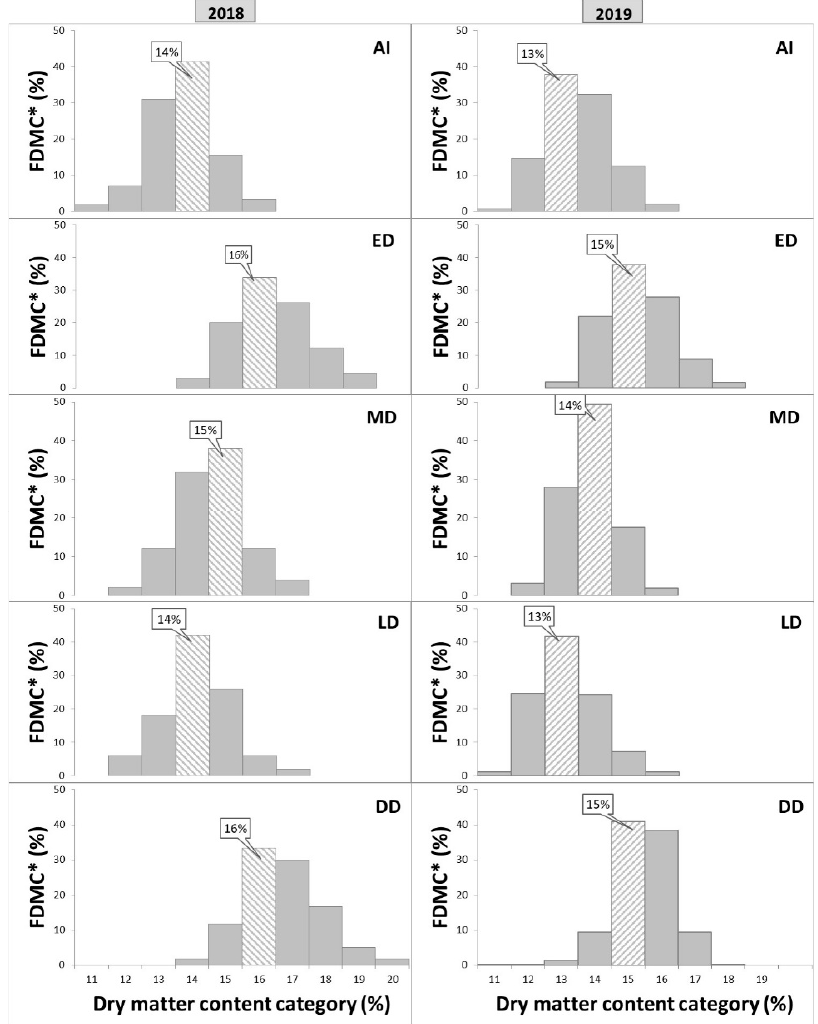
Figure 4. Frequency distribution of the predicted dry-matter content (FDMC*) categories of Ambrosia™ apples near harvest from a commercial orchard in Cawston, BC, Canada. The left panel shows the category of 2018. The right panel shows the category of 2019. FDMC: frequency in dry-matter categories, as illustrated by the apple DMC analysis [14]. AI = adequate irrigation; ED = early-summer deficit irrigation (DI); MD = middle-summer DI; LD = late-summer DI; DD = double-period DI. The number within a text box on top of the highest column in each panel indicates the principal (or highest) category of DMC, which was determined with analysis using the SAS General Linear Models procedure ( p ≤ 0.05).